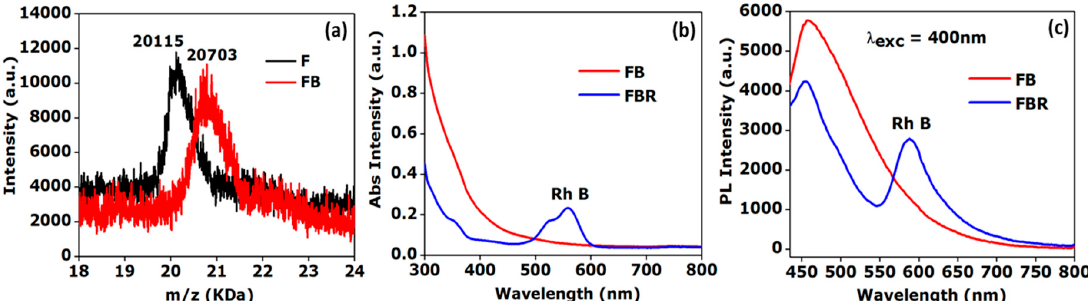
Figure 2. Characterizations of the ferritin-biotin-rhodamine complex in solution: ( a ) Matrix-assisted laser desorption/ionization time-of-flight (MALDI-ToF) spectra of ferritin (black curve, calculated MW—19,500 Da, measured MW—20,115 Da) and of the ferritin-biotin complex subunit (red curve, calculated MW—20,182 Da, measured MW—20,703 Da), ( b ) absorbance spectra, and ( c ) photoluminescence spectra of ferritin-biotin (FB) and the ferritin-biotin-rhodamine (FBR) complex.